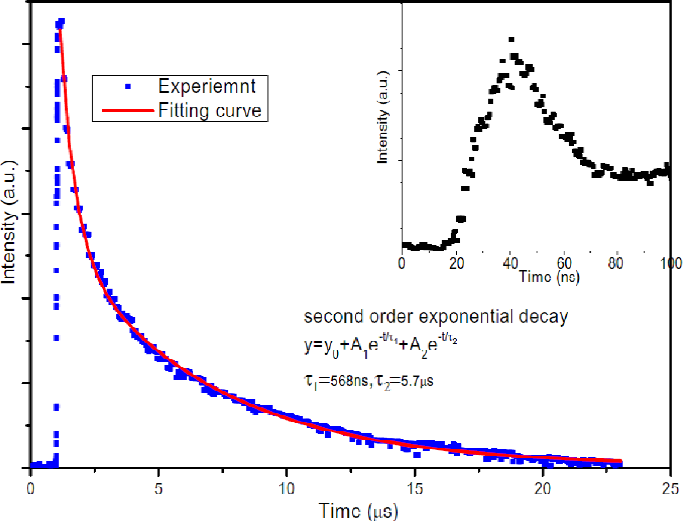
Figure 2. Temporal response of ZnO UV detectors excited by Nd–YAG laser pulses (355 nm, <10 ns). The inset shows the enlarged impulse response